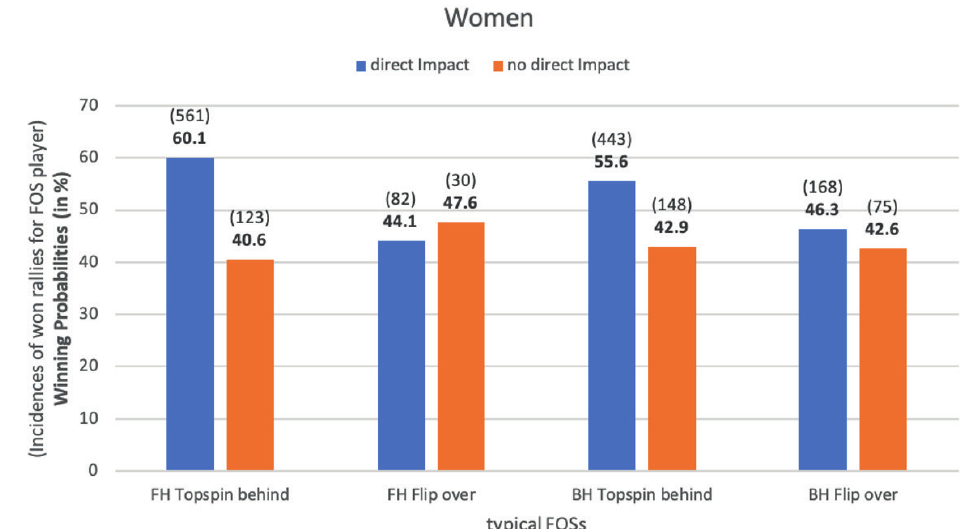
Figure 10. Incidences of won rallies and winning probabilities for the FOS player using the typical FOSs separated by direct or no direct impact of the FOS for women’s